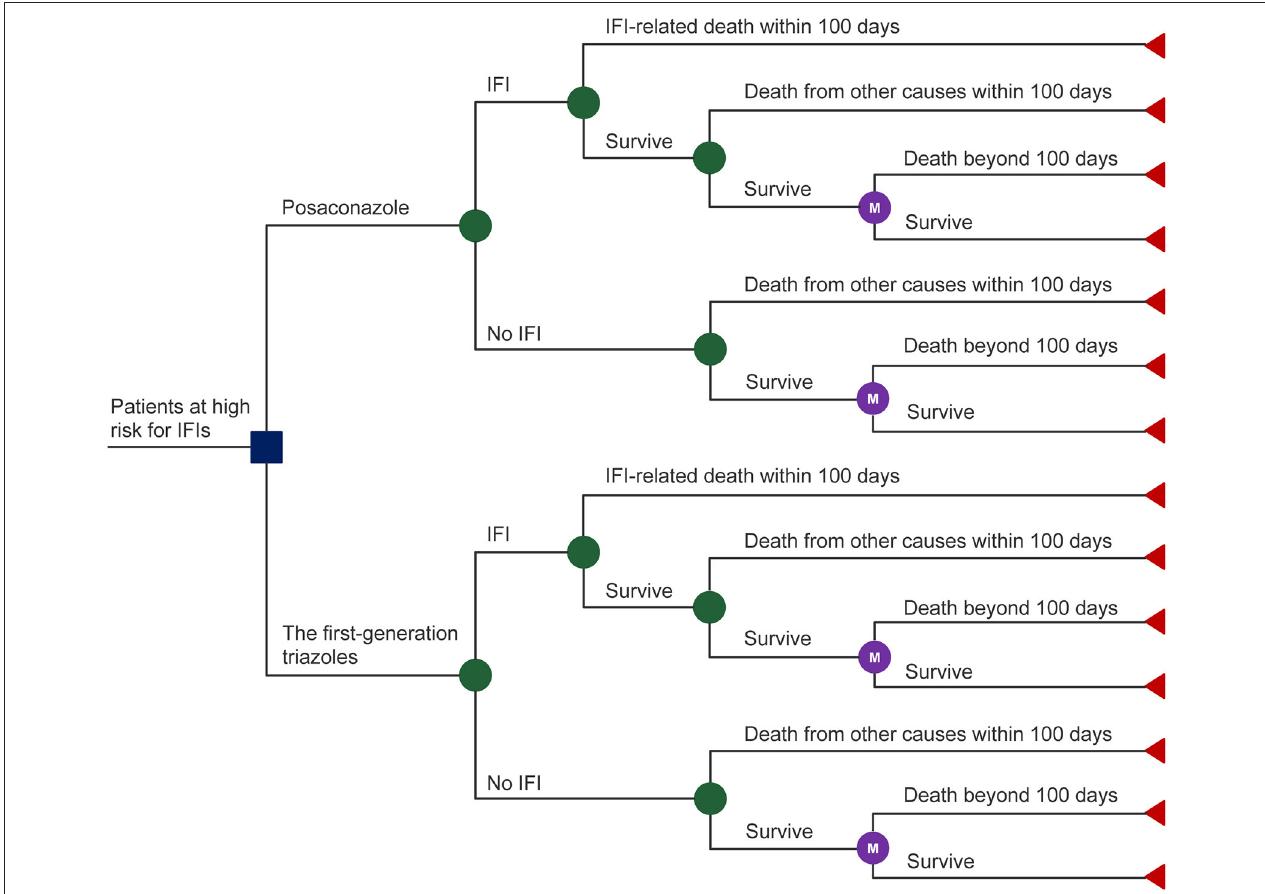
FIGURE 1 | Structure of the model for